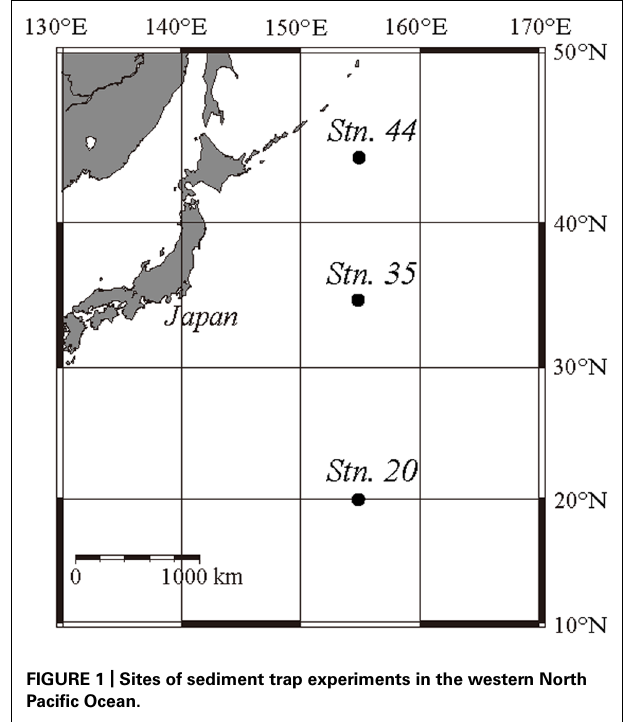
FIGURE 1 | Sites of sediment trap experiments in the western North Pacific Ocean.